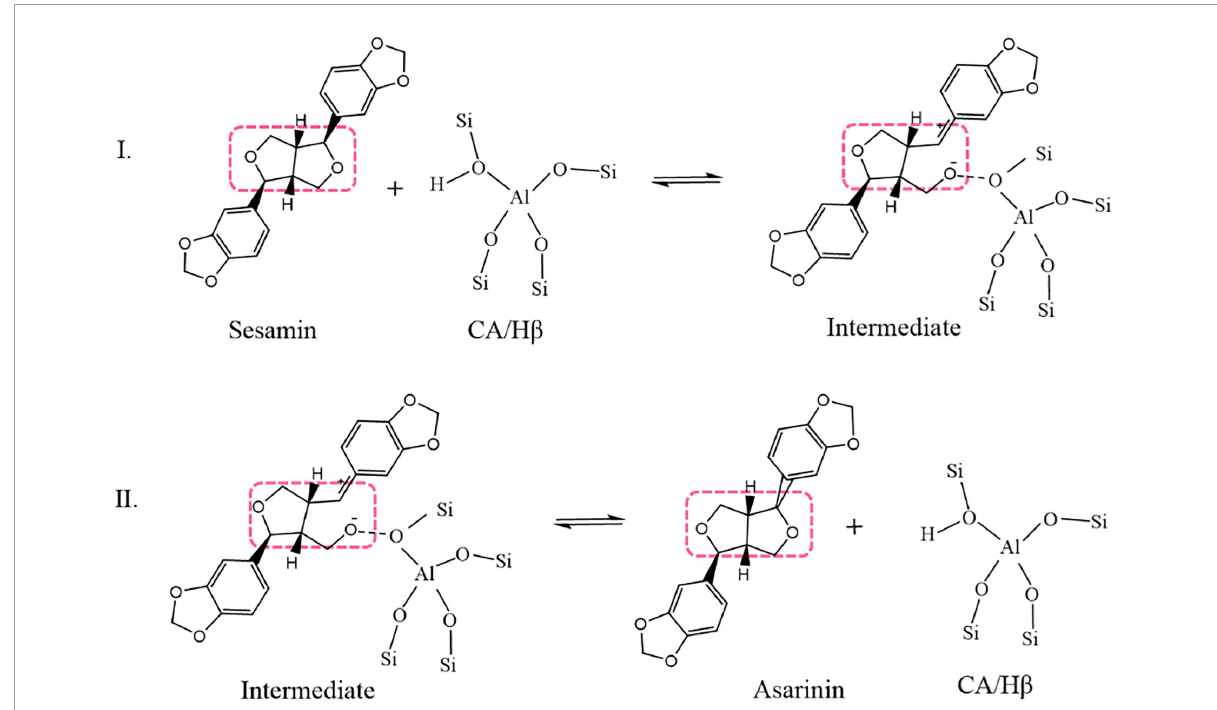
FIGURE1 Simplified mechanism of sesamin conversion in sesame oil (dotted boxes enclose tetrahydrofuran rings).